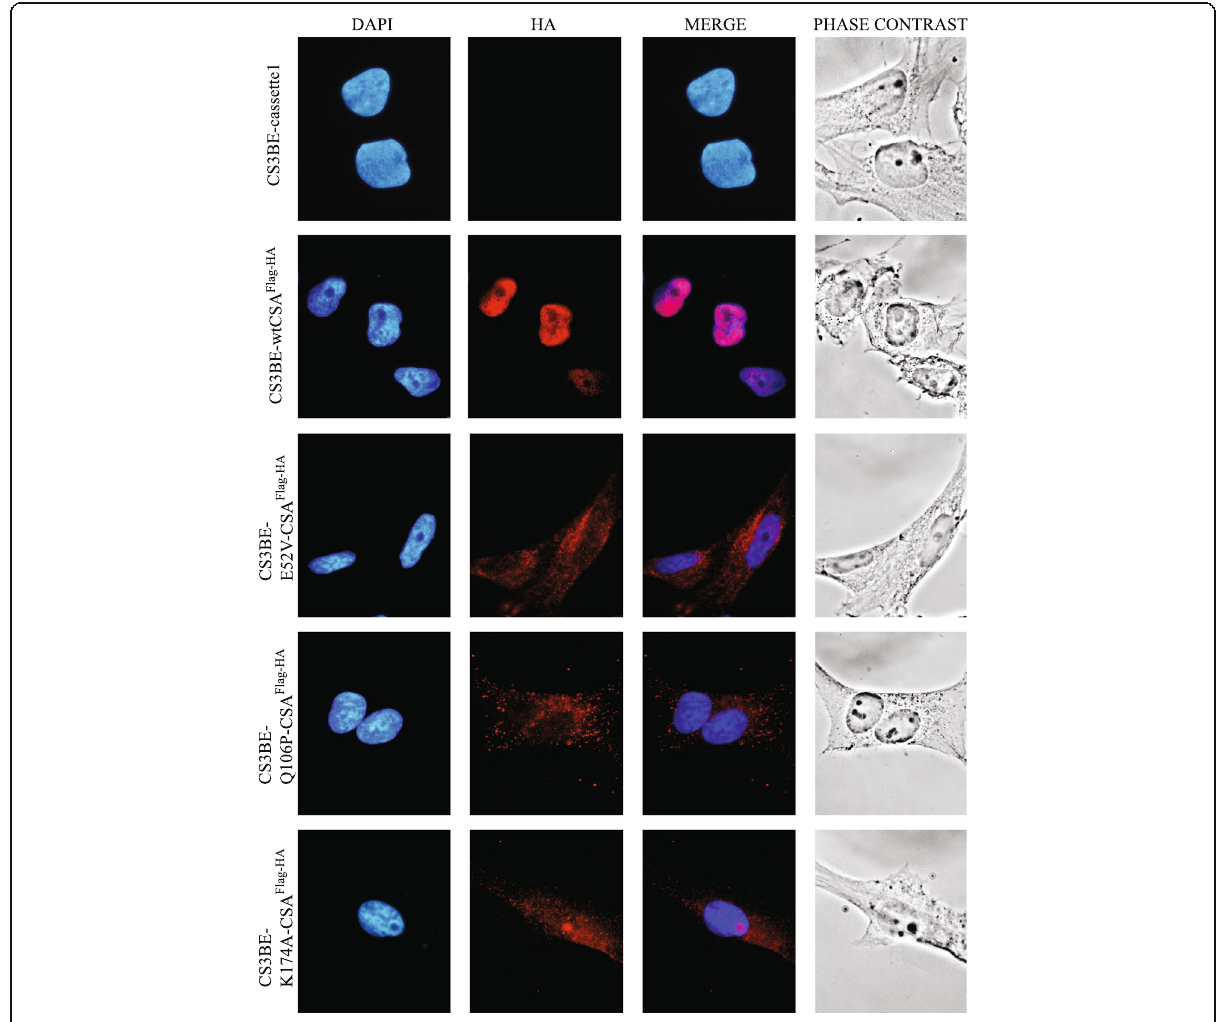
Fig. 1 Subcellular localization of the recombinant CSA Flag-HA proteins. Immunofluorescence staining with anti-HA antibodies ( red ) in